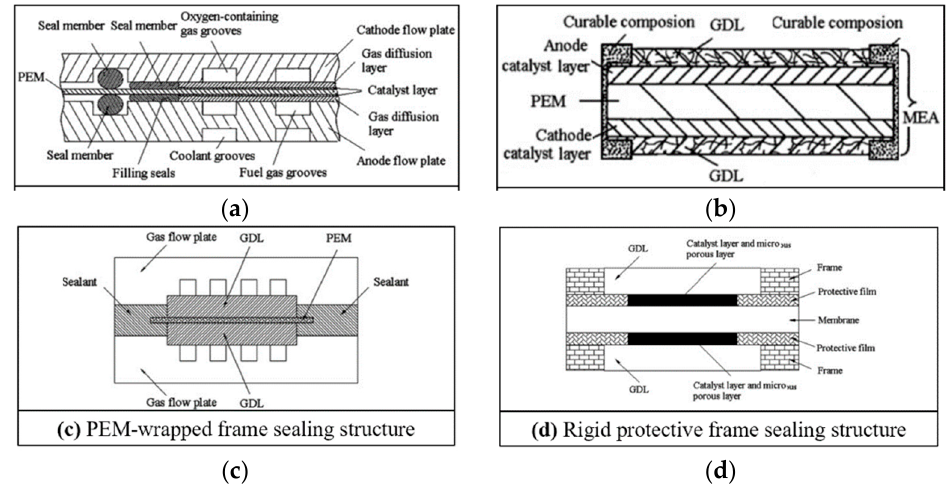
Figure 2. Schematic diagram of the frame structures [22]. ( a ) PEM direct sealing structure; ( b ) MEA- wrapped frame sealing structure; ( c ) PEM-wrapped frame sealing structure; ( d ) rigid protective frame sealing structure.